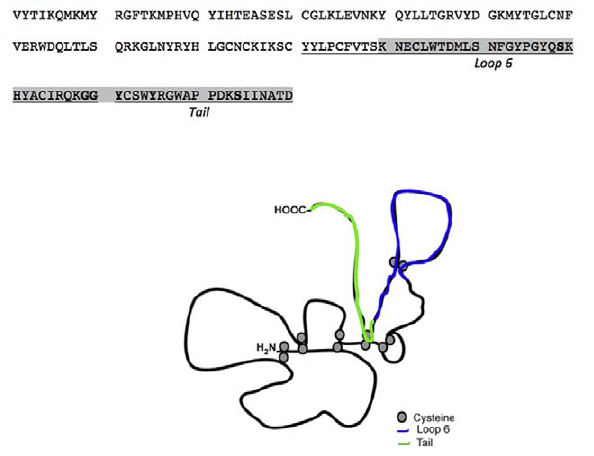
Figure 8. Location of Loop 6 and Tail TIMP-3 peptides on TIMP- 3